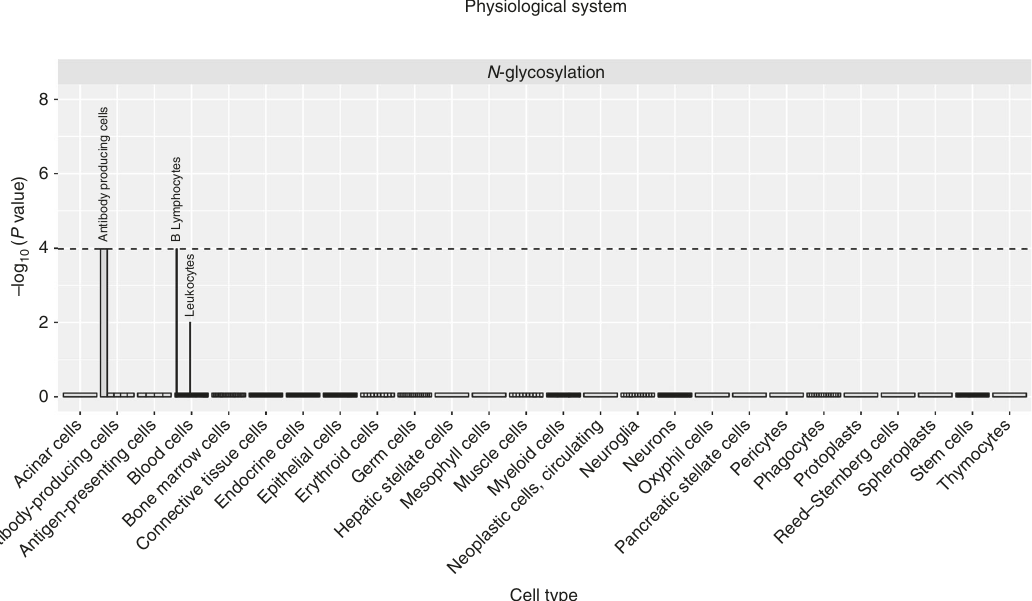
Fig. 3 DEPICT enrichment analysis results for IgG N-glycosylation loci. ( a ) Tissues. ( b ) Cell types. Genes in the associated loci are highly expressed in cells and structures of the hemic and immune systems (with emphasis on antibody-producing cells), and to a lesser degree in the skeleton and glands of the digestive system. See Supplementary Data 2 for